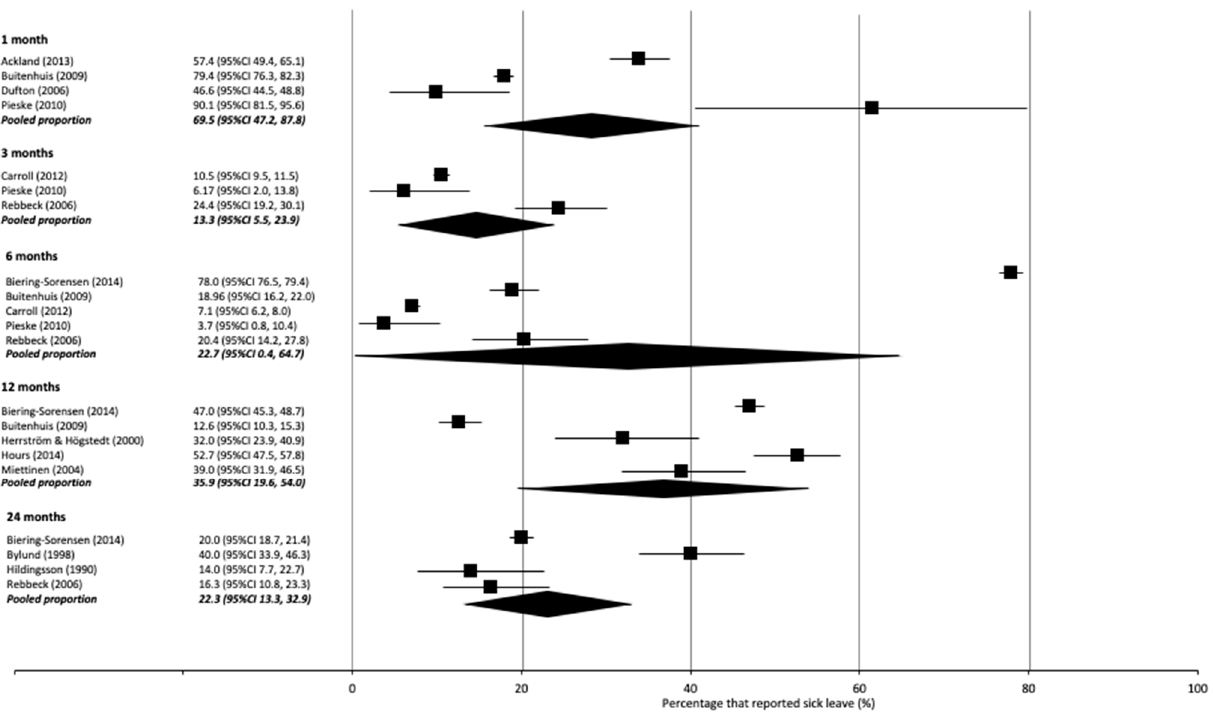
Figure 3. Forest plot with percentages and pooled percentage of participants taking sick leave as reported per time point (1, 3, 6, 12 and 24 months).